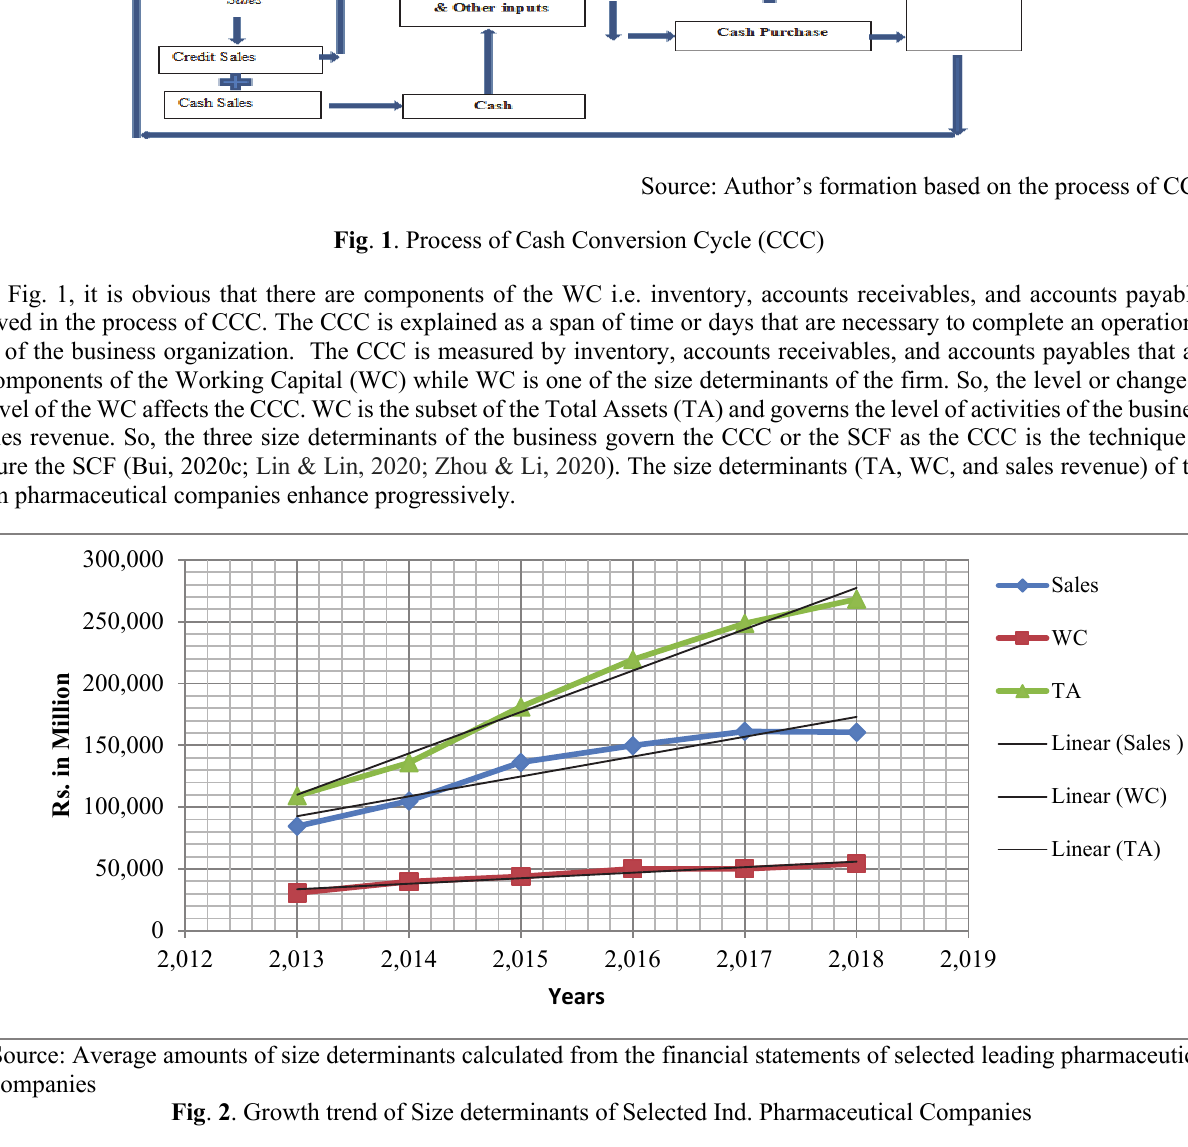
Fig . 2 . Growth trend of Size determinants of Selected Ind. Pharmaceutical